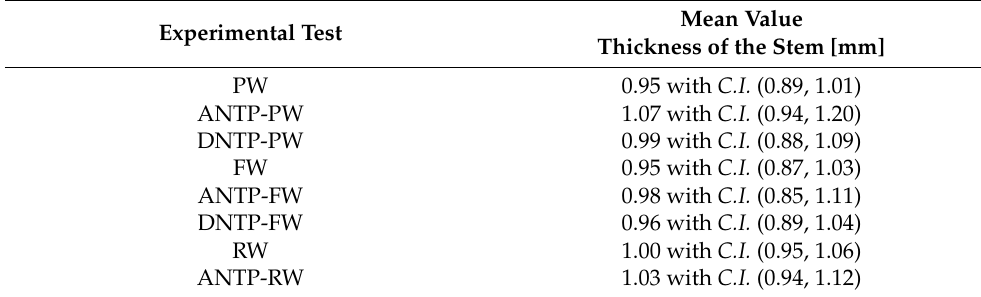
Table 4. The thickness of the stem registered as a result of different treatments.